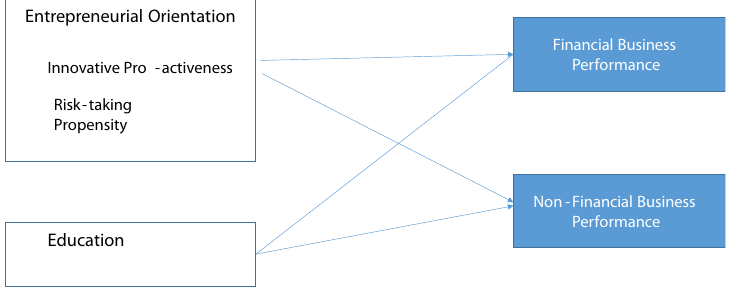
Figure 1. Research